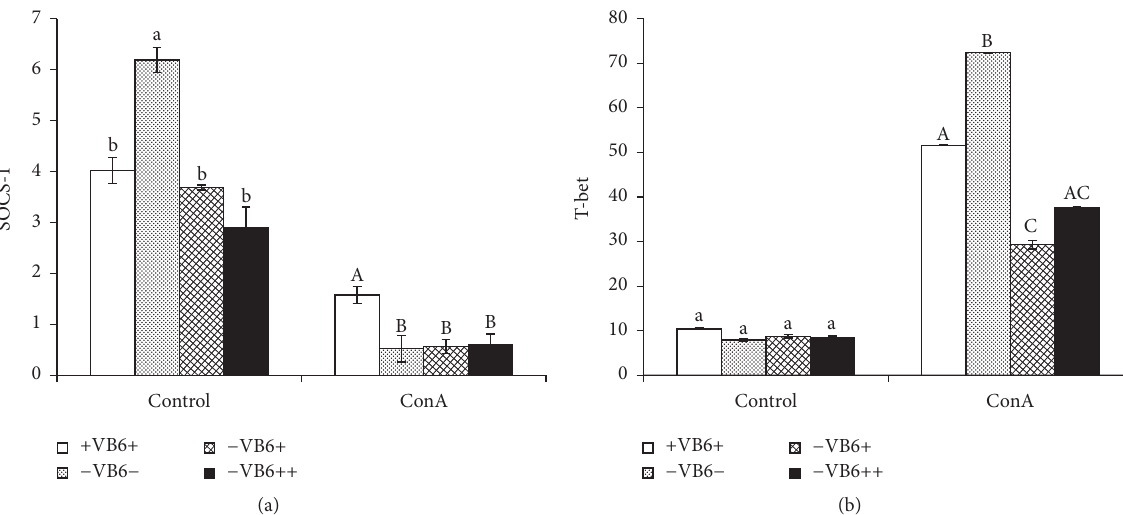
Figure 5: Real-time RNA results. mRNA SOCS-1 (a), T-bet (b) expression level of different vitamin B6 diet mice splenocytes after ConA stimulation. 5 𝜇 g/mL ConA was added to stimulate the splenocyte, while the control received the same volume of RMPI1640 medium. After 24 h of incubation, mRNA was extracted and reversed. Each column represents the mean ± SD ( 𝑛 = 7 ) with three independent experiments. Columns marked with different letters are significantly different ( 𝑃 < 0.05 ) among different diet